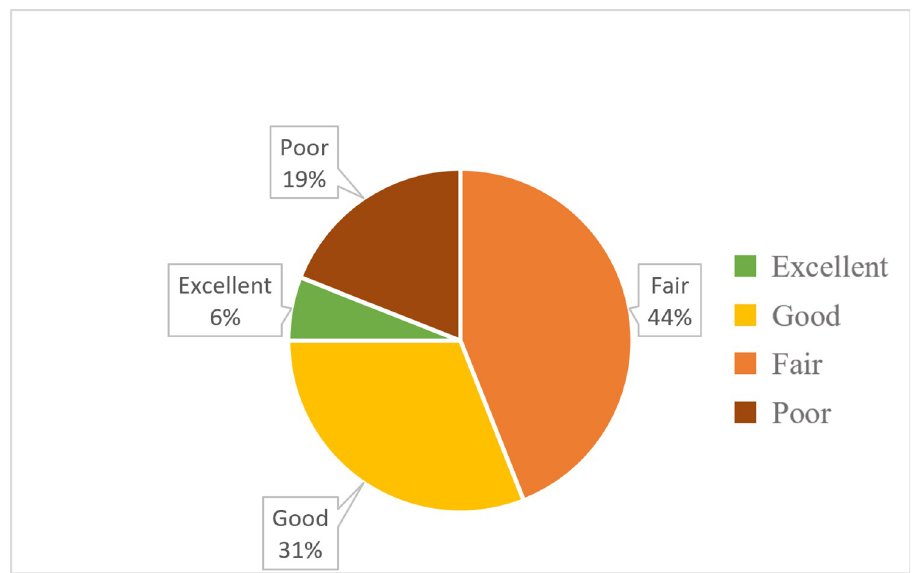
Fig 1. Percentages of Health Center III grading outcomes for assessed cervical cancer services.